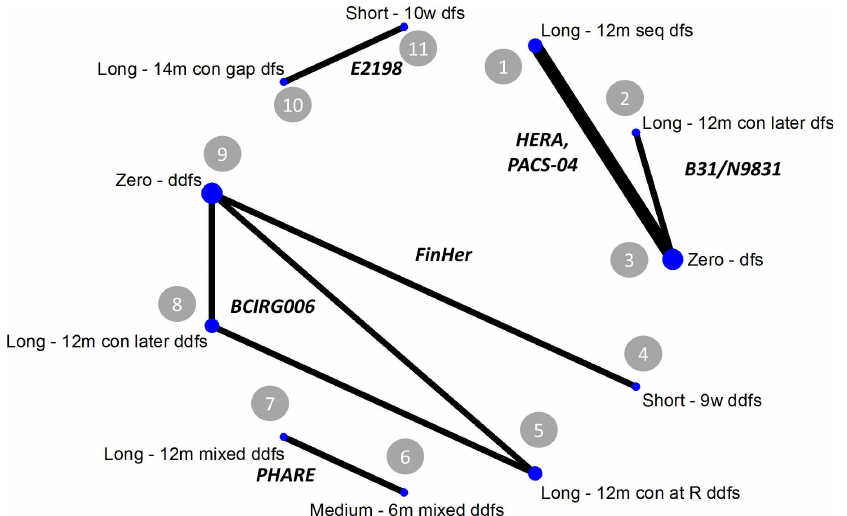
Fig 1. Full 11-node map, showing the four distinct jointly randomisable networks made up of the different regimens, characterised by trastuzumab duration, timing of administration, and type of disease-free endpoint reported. (Key: 14m = 14 months’ trastuzumab; 12m = 12 months’ trastuzumab; 6m = 6 months’ trastuzumab; 10 = 10 weeks’ trastuzumab; 9w = 9 weeks’ trastuzumab; gap = 3-month gap in trastuzumab administration; con = given concomitantly with taxane; seq = given sequentially with taxane; mixed = results were not broken down by administration; at R = trastuzumab begunat randomisation; later = trastuzumab begun some months after randomisation; ddfs = distant disease-free survival; dfs = disease-free survival; os = overall